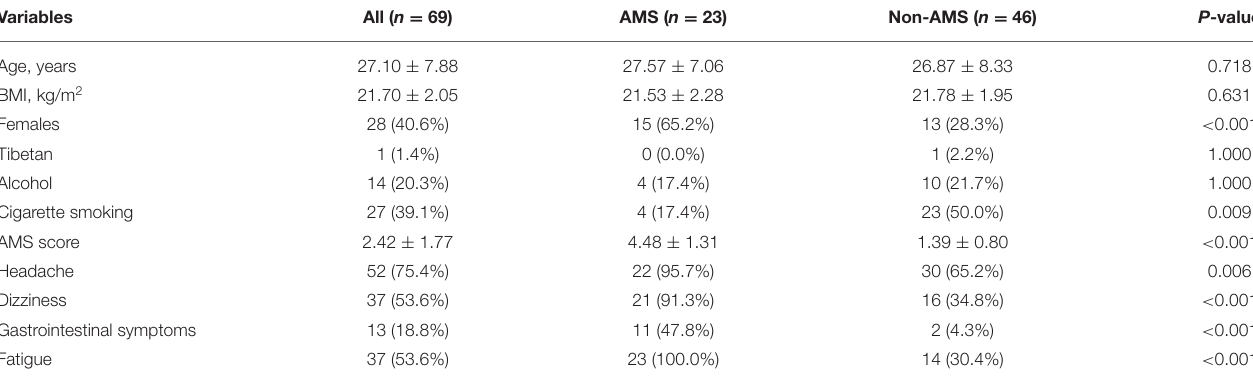
TABLE 1 | Demographic and AMS symptoms parameters.